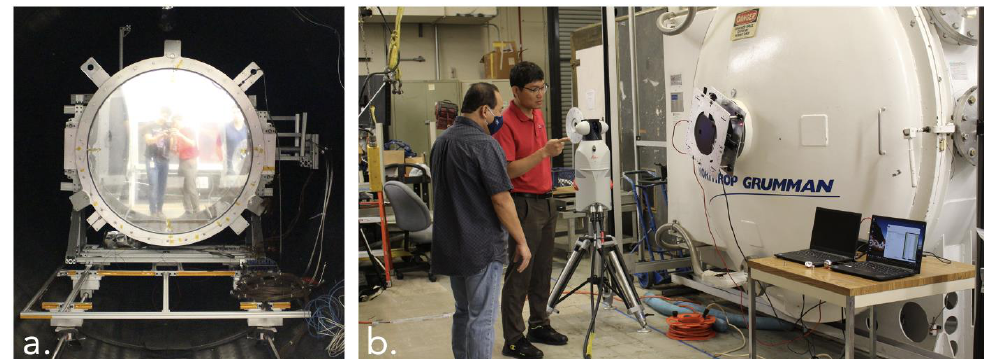
Figure 7. The inflated test article is mounted at back of the chamber cylinder ( a ). The scale of the entire test configuration was nearly 4 m, which places the deflectometer approximately at the radius of curvature of the inflated optic at its inflation pressure range of 500 – 700 Pa ( b ). During testing, the first Fresnel reflection at the acrylic window interface was faint enough to not significantly reduce signal contrast at the camera detector. Diffuse machined internal surfaces scatter the illumination from outside the chamber, also slightly reducing reconstruction signal contrast.